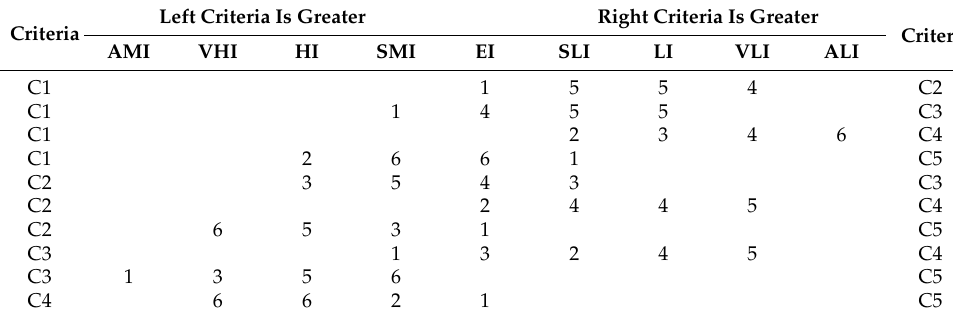
Table 2. Pair-wise comparison matrix of criteria.